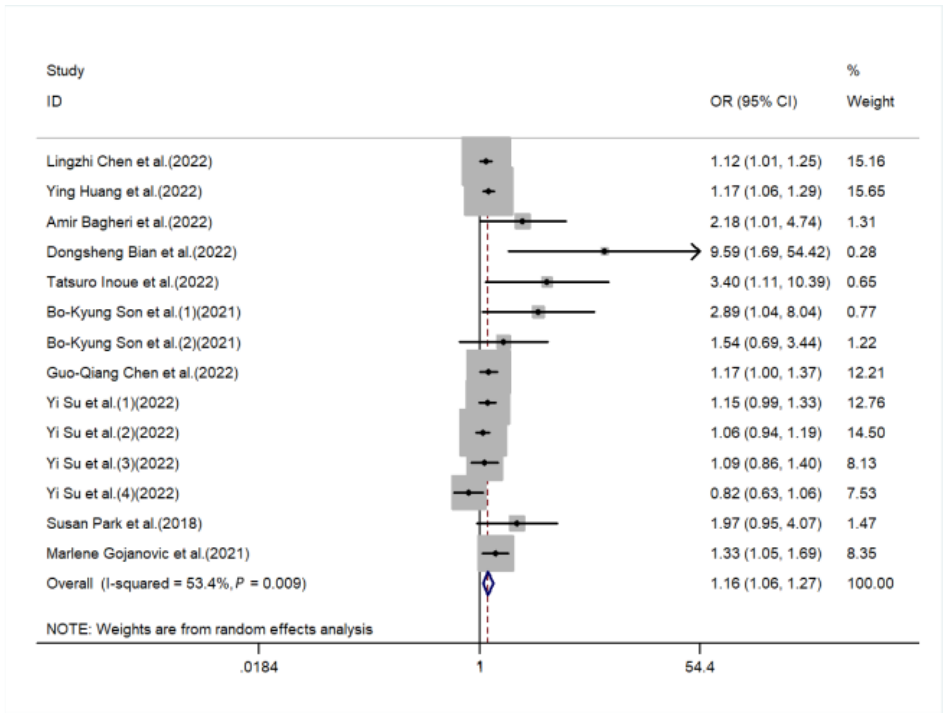
Figure 2. Forest plot of the risk of sarcopenia in subjects with a high DII vs. a low DII [19-29] .